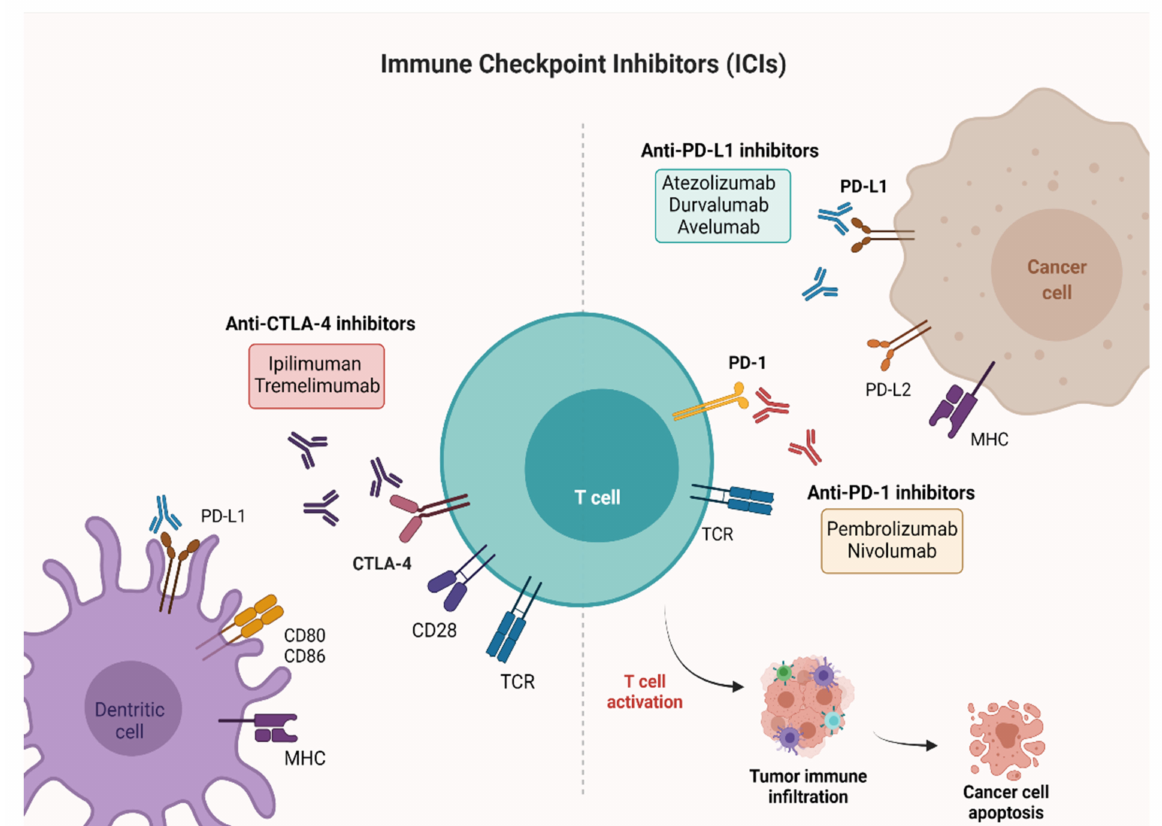
Figure 1. Mechanisms of action of ICIs targeting PD-1, PD-L1, and CTLA-4. PD-1 and CTLA-4 are proteins expressed on activated T cells. Their binding to the respective ligands presented on the surface of cancer cells leads to T cell inactivation and prevents tumor cell death. The immune checkpoint blockade ensures the activation of T cells and favors antitumor activity. Created with BioRender.com (accessed on 26 July 2021). PD-1: Programmed cell death-1; PD-L1: Programmed cell death-ligand 1; CTLA-4: Cytotoxic T-lymphocyte-associated antigen